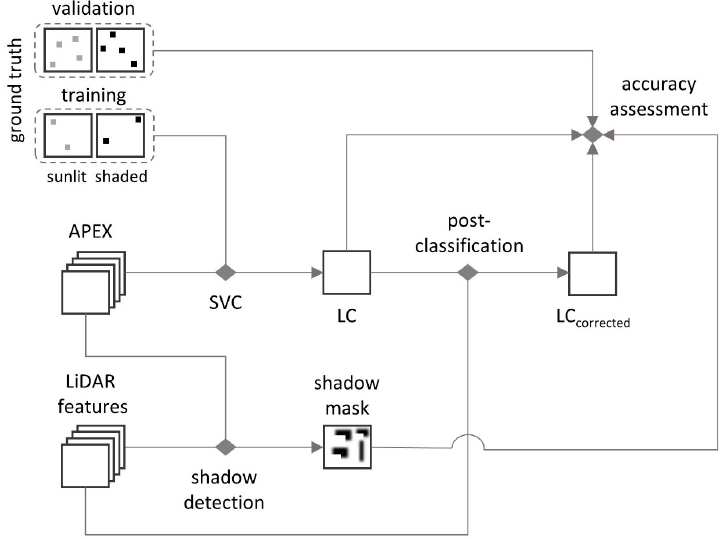
Figure 3. Flowchart outlining the workflow implemented in this research.